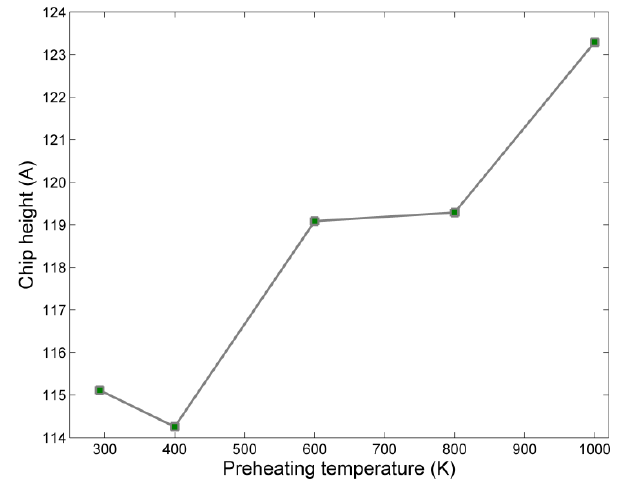
Figure 8. Chip height variation with respect to preheating temperature.